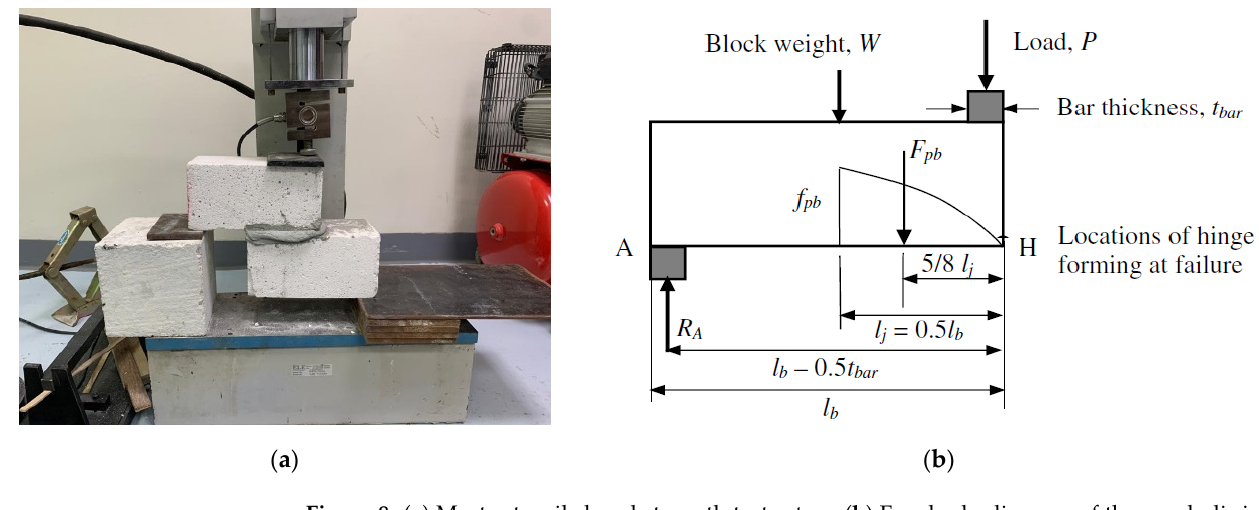
Figure 8. ( a ) Mortar tensile bond strength test setup. ( b ) Free body diagram of the parabolic joint force distribution according to [42]. Table 3. Compressive strength test results of the mortar cubes.